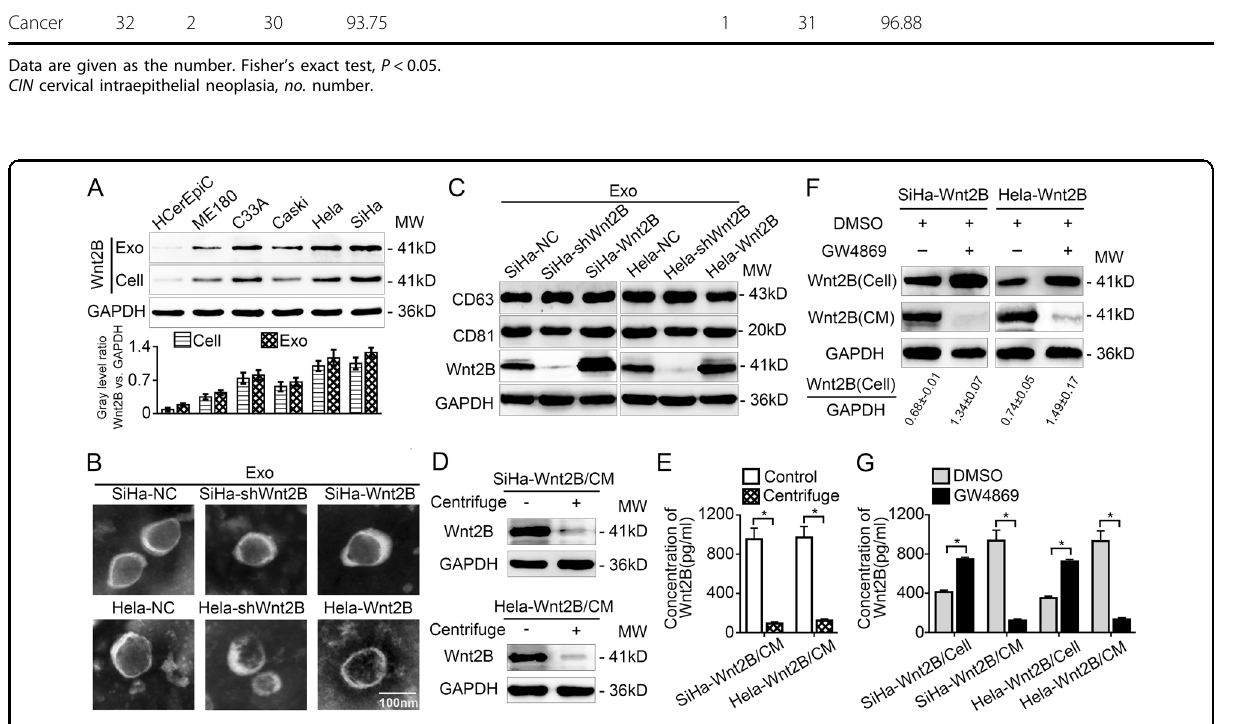
Fig. 2 Wnt2B is highly enriched in exosomes secreted by CC cells. A Western blot analysis for Wnt2B in HCerEpiC, ME180, C33A, Caski, Hela, and SiHa cells and their corresponding exosomes. B Morphology of exosomes secreted by SiHa and Hela cells con fi rmed using transmission electron microscopy. Scale bar, 100 nm. C Western blot analysis for positive markers (CD63 and CD81) and Wnt2B expression in exosomes secreted by SiHa and Hela cells. D , E Western blot and ELISA analyses for Wnt2B in original CM from SiHa-Wnt2B or Hela-Wnt2B cells, or after overnight ultracentrifugation (160,000× g ). F , G Western blot and ELISA analyses for Wnt2B in the cell lysates and CM of SiHa-Wnt2B or Hela-Wnt2B treated with DMSO or GW4869 (15 μ M) for 2 days. A , C , D , F Exosomes or CM secreted by the same number of cells; glyceraldehyde 3-phosphate dehydrogenase (GAPDH) was used as the loading control. Error bars represent the mean ± SD of three independent experiments. * P < 0.05.